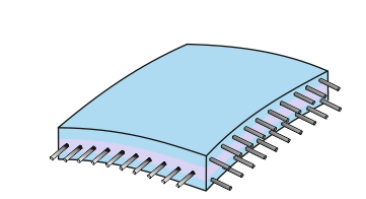
Figure 1. An example of a FRC three-layer